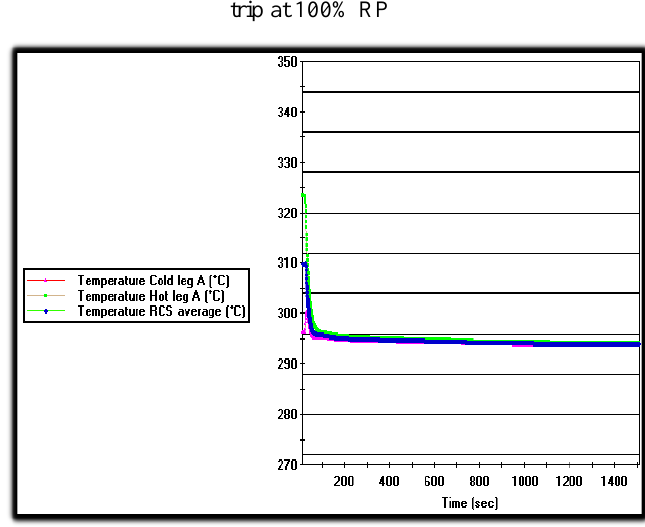
Fig. 13. Transient reactor coolant pressure under reactor